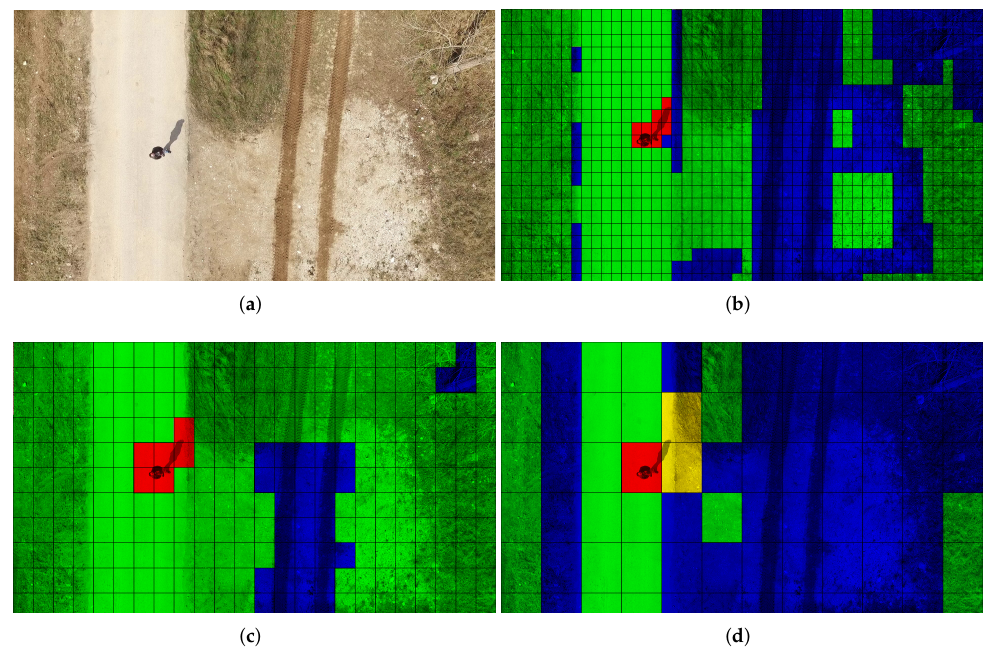
Figure 5. Output generated using different patch sizes. The red and green patches indicate, respec- tively, anomalous and normal patches correctly classified. Blue patches correspond to normal patches classified as anomalies. Yellow patches represent anomalous patches classified as normal. ( a ) Input image with an anomaly, i.e., a man and his shadow. ( b ) Anomaly detection output using a 40 × 50 patch size. ( c ) Anomaly detection output using an 80 × 100 patch size. ( d ) Anomaly detection output using a 160 × 200 patch